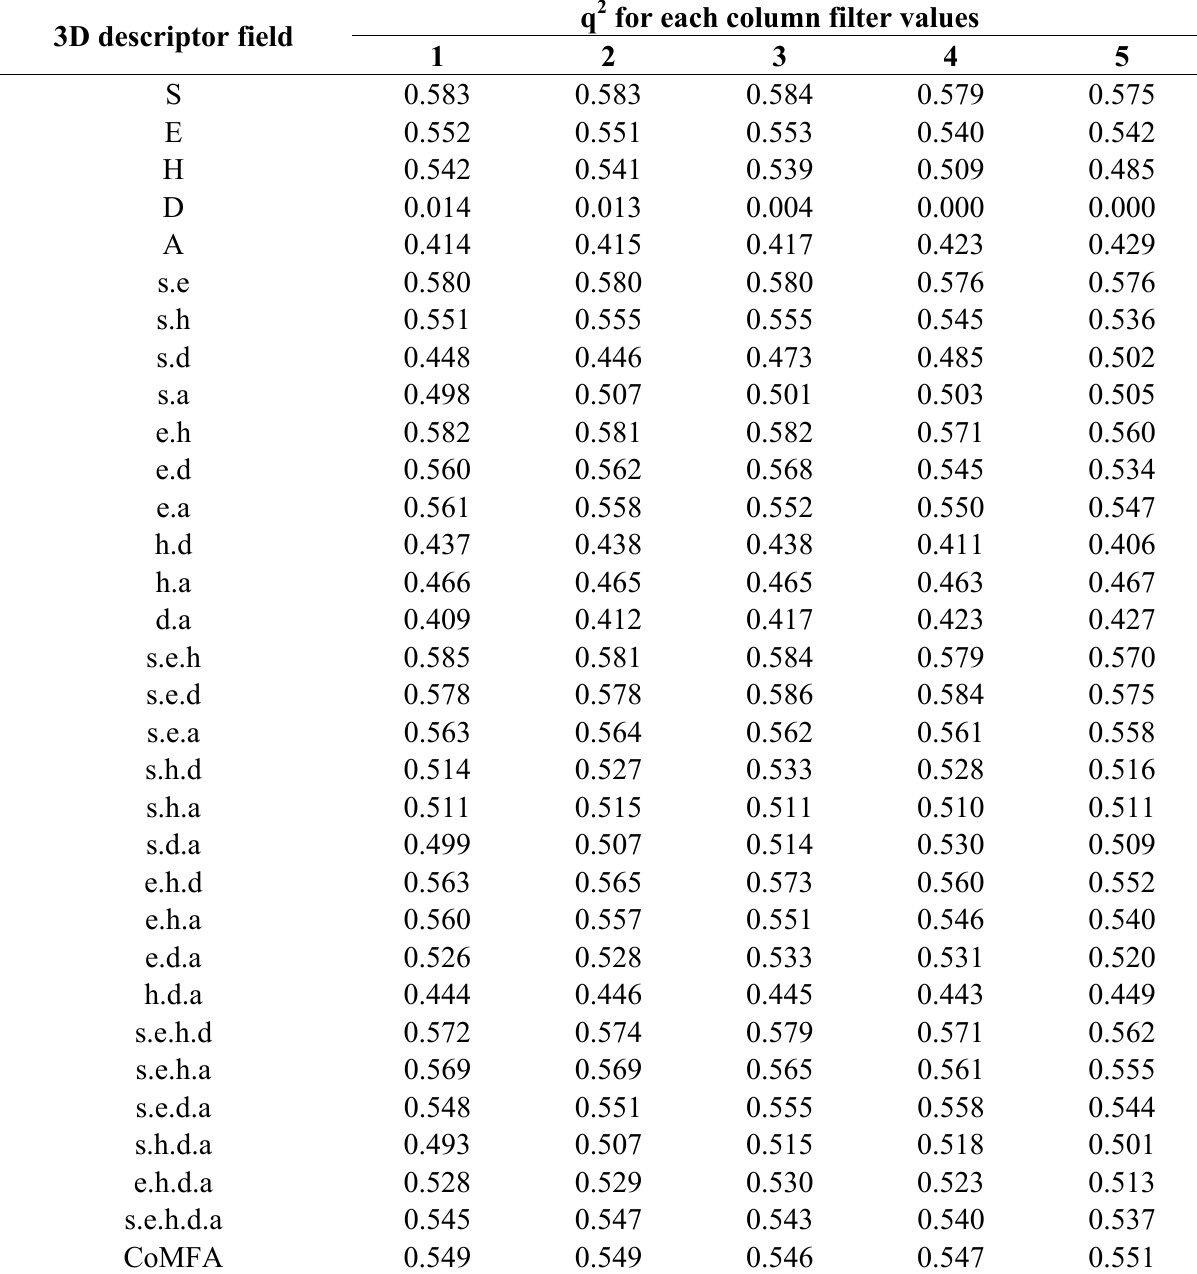
Table 8. Cross-validation results of 3D-QSAR with KB3-1